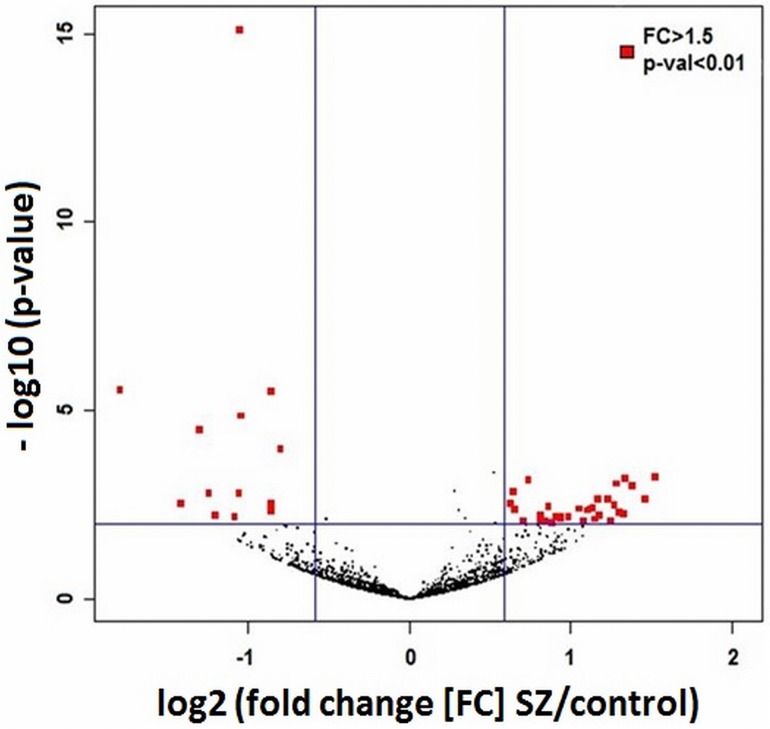
Volcano plot showing statistical significance (-log10 of the p-values) on the y-axis vs fold change of all expressed miRNAs.The 13 miRNAs that were significantly down-regulated in SZ are shown at the left (red squares), while the 32 that were significantly up-regulated in SZ are shown at the right (p < 0.05 and FC > 1.5).